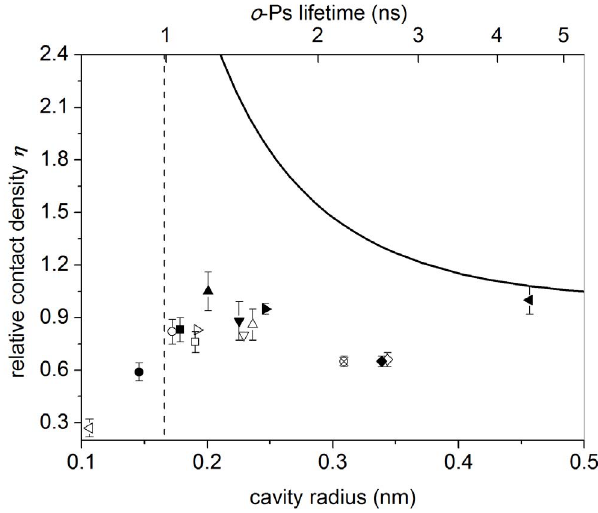
Figure 3. Relative contact density and o -Ps lifetime as measured in some molecular solids and polymers (symbols are explained in Table 1).